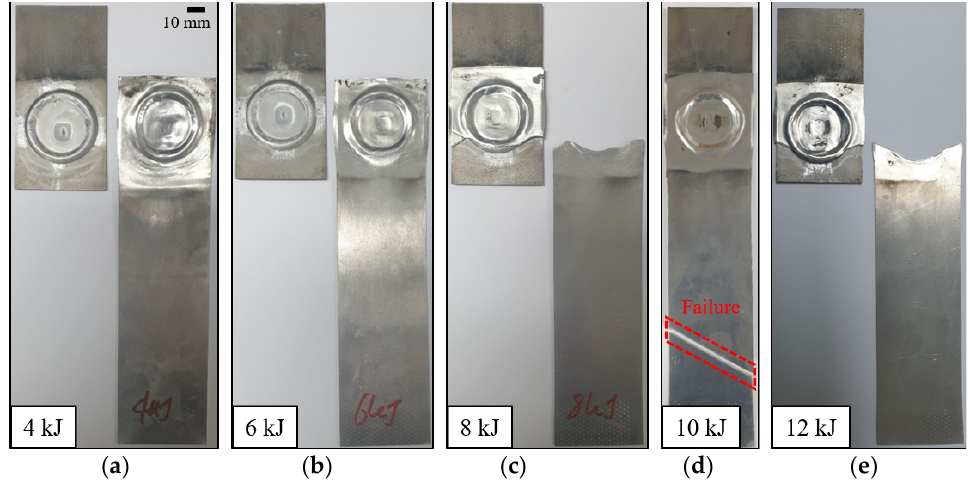
Figure 11. Test specimens after lap shear tests with respect to the input energy: ( a ) 4 kJ; ( b ) 6 kJ; ( c )